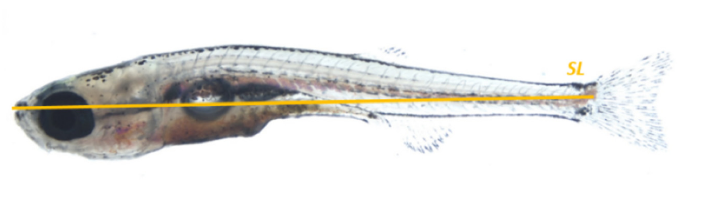
Fig 1. Standard length (SL) as described by Parichy et al [27]. SL is the distance from the snout to the caudal peduncle. In pre-flexion larvae that do not have a caudal penduncle, SL is the distance from the snout to the posterior tip of the notochord.